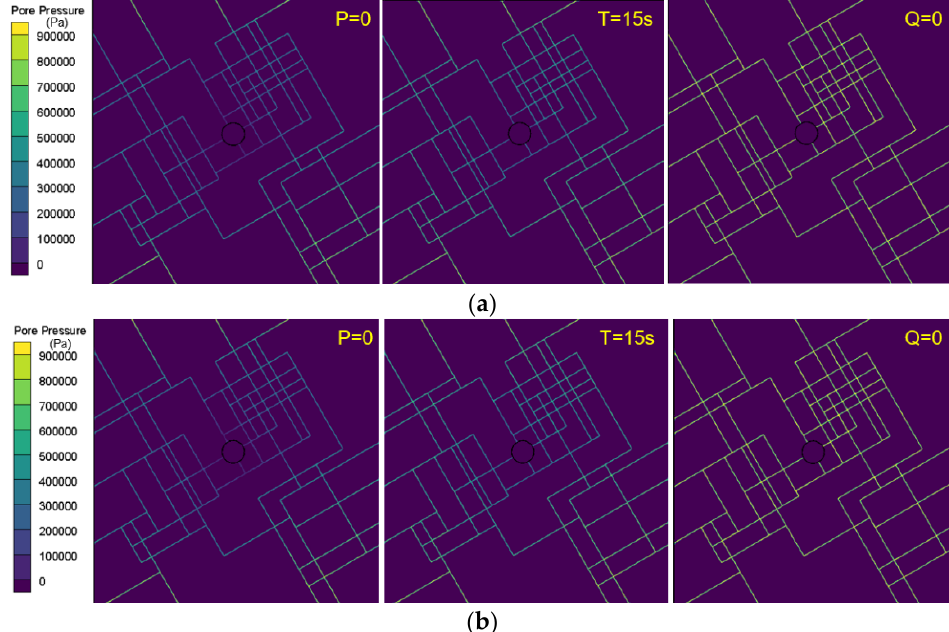
Figure 22. Contour map of pore pressure in the fractures before and after excavation and support: ( a ) aperture is 1 mm; ( b ) aperture is 0.1